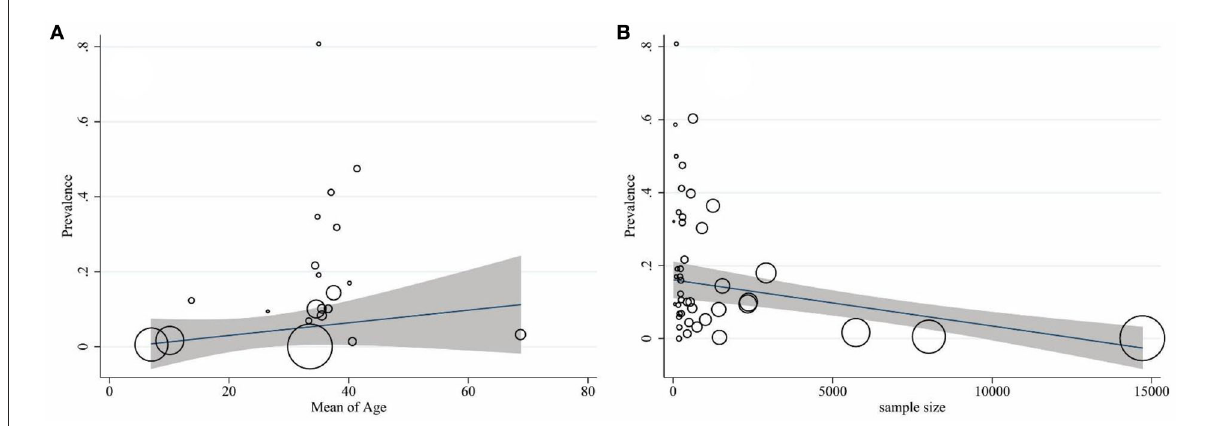
of raw milk (56). Socio-economic factors, improvement of